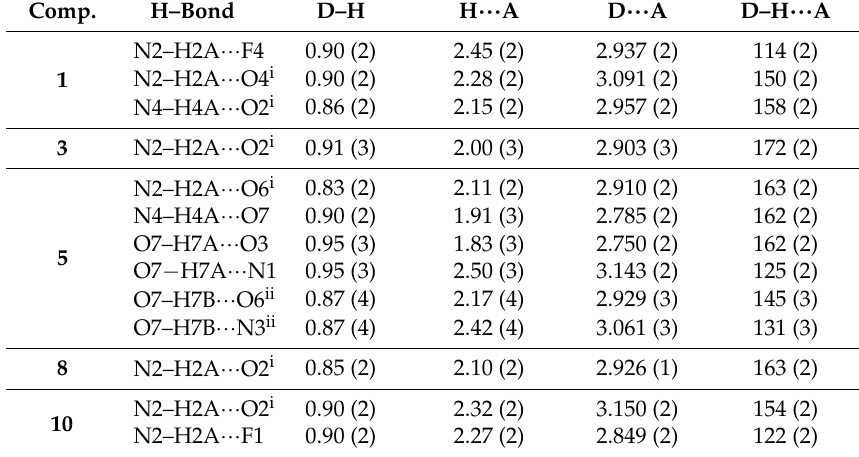
Table 2. Hydrogen-bonding geometries (Å, ◦ ) for 1 , 3 , 5 , 8 and 10 .